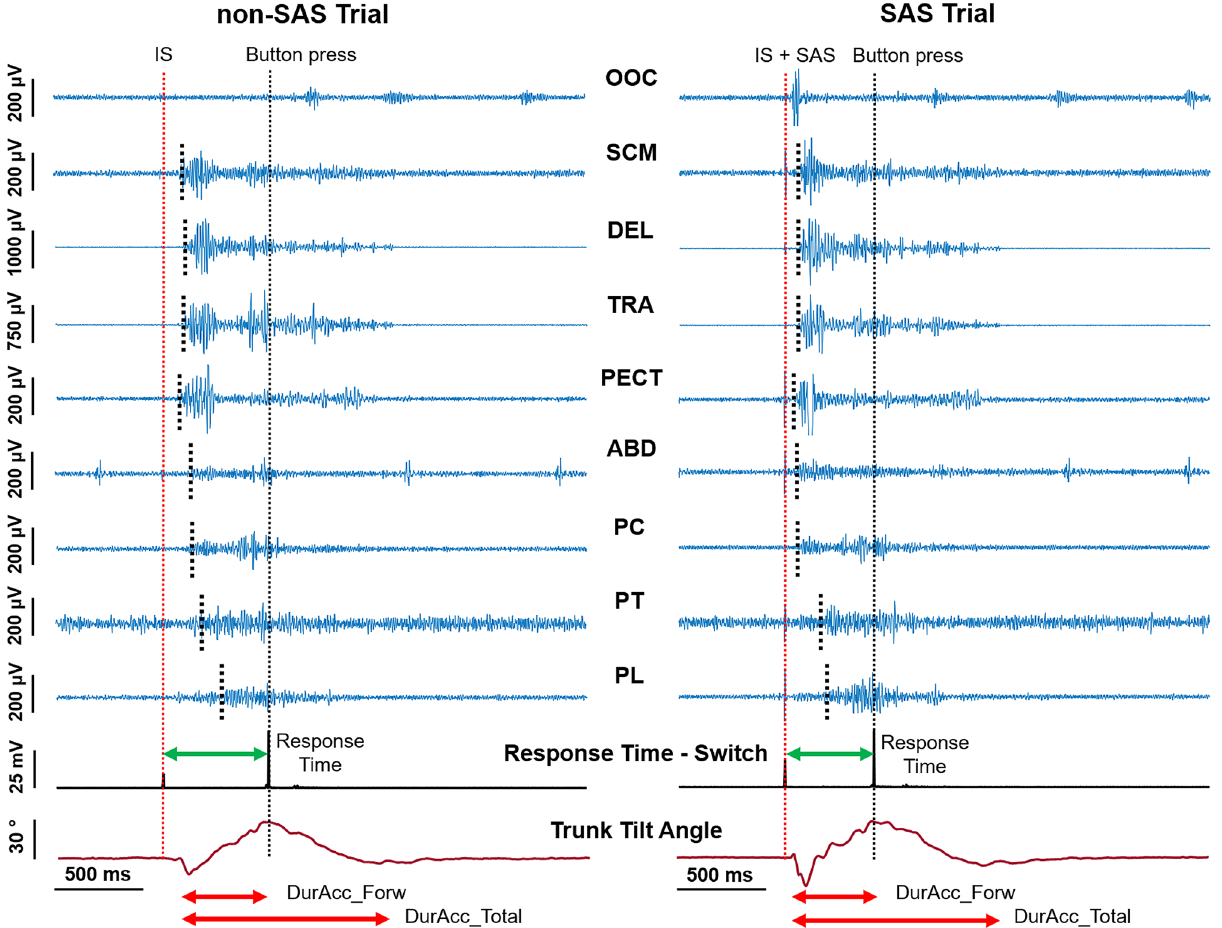
Figure 3. Example of the signals recorded during the trunk movement task at 15 cm. From top to bottom: EMG recordings of the OOc, SCM, DEL, TRA, PECT, ABD, PC, PT, and PL; artifact signal from the switch button, indicating the response time, and trunk tilt angle (θ) derived from the smartphone accelerometer. Small black dotted lines indicate the onset latencies of each muscle. The vertical dotted lines indicate the imperative signal (IS) (red), and the button press time (black). The response time until the button press is indicated with green arrows. The red arrows indicate the duration of the forward movement (DurAcc_Forw) and the total duration of the movement (DurAcc_Total) measured from the accelerometer